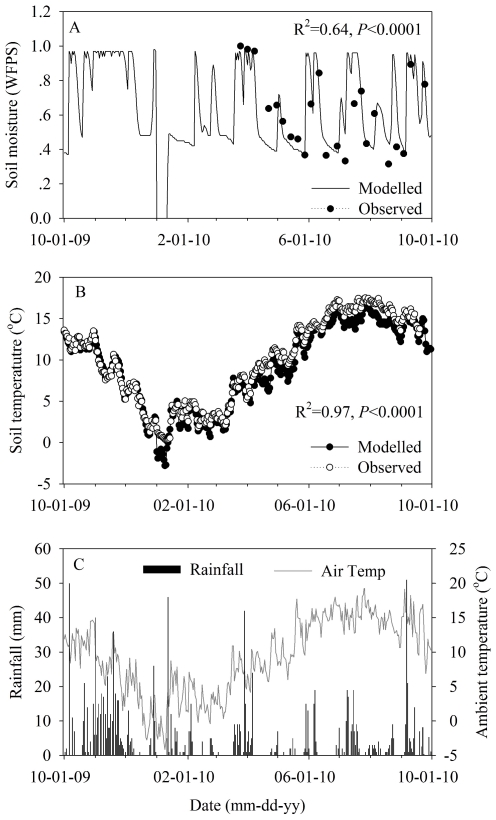
Soil microclimatic and weather conditions.(A) Simulated and measured soil water filled pore space (WFPS) at 5 cm depth, (B) simulated and measured soil temperature at 5 cm depth, and (C) daily rainfall and air temperature. Note: only measured soil moisture and temperature for GG+FN paddocks are presented here as an example.